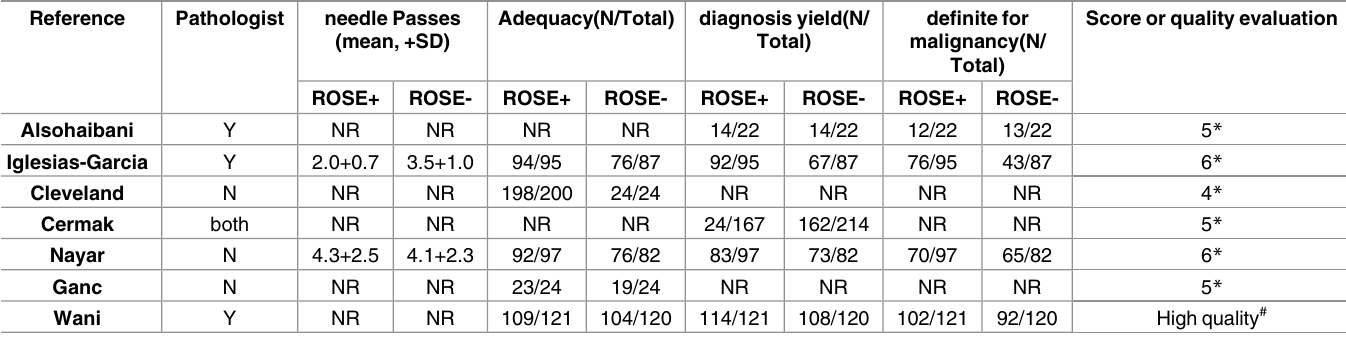
Table 2. Outcome measuresfor individual studies of meta-analysis comparing EUS-FNA with and without ROSE.